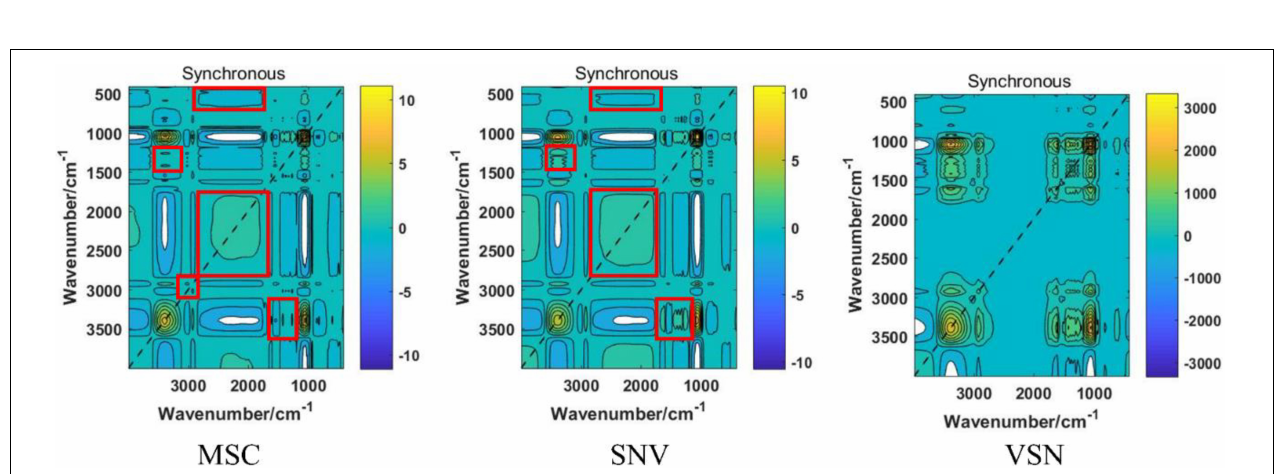
FIGURE 4 | The reprehensive synchronous 2DCOS images of three preprocessing methods, including MSC, SNV, and VSN. The regions in the red boxes reflect the significant differences between MSC and SNV.